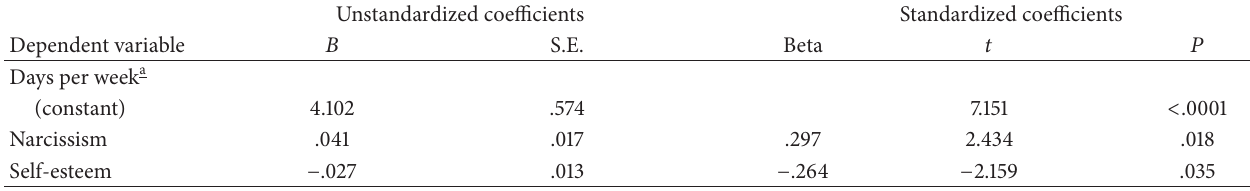
Table 5: Stepwise regression analysis, Model 2. Excluded variables: Authority, Superiority, and Exploitativeness. Unstandardized